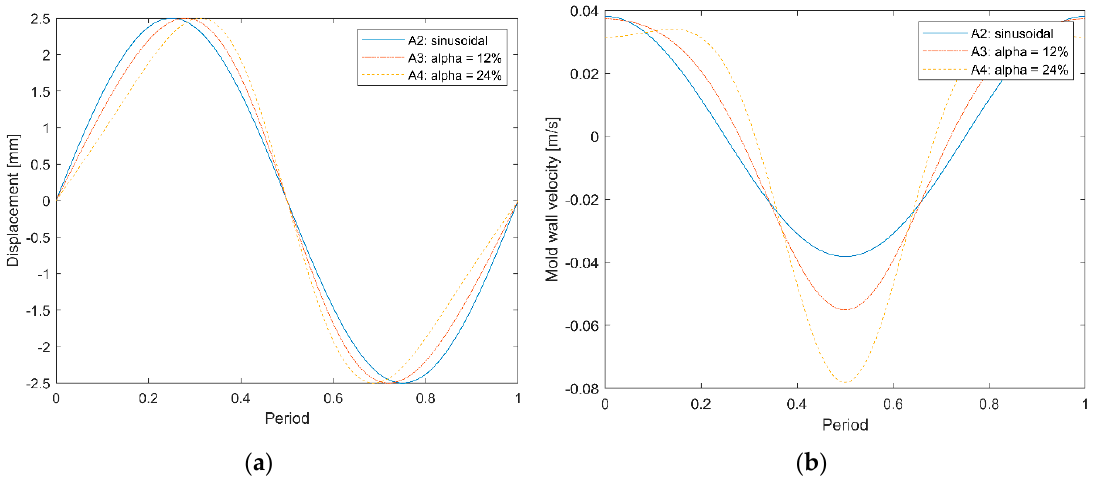
Figure 7 visualizes mold displacement and velocity for Case A2 (sinusoidal), A3 ( α = 12% ) , and A4 ( α = 24% ) calculated by Equations (10) and (11). It shows a clear trend from Figure 7b that the NST becomes narrower but the descending velocity becomes faster as the modification ratio increases.